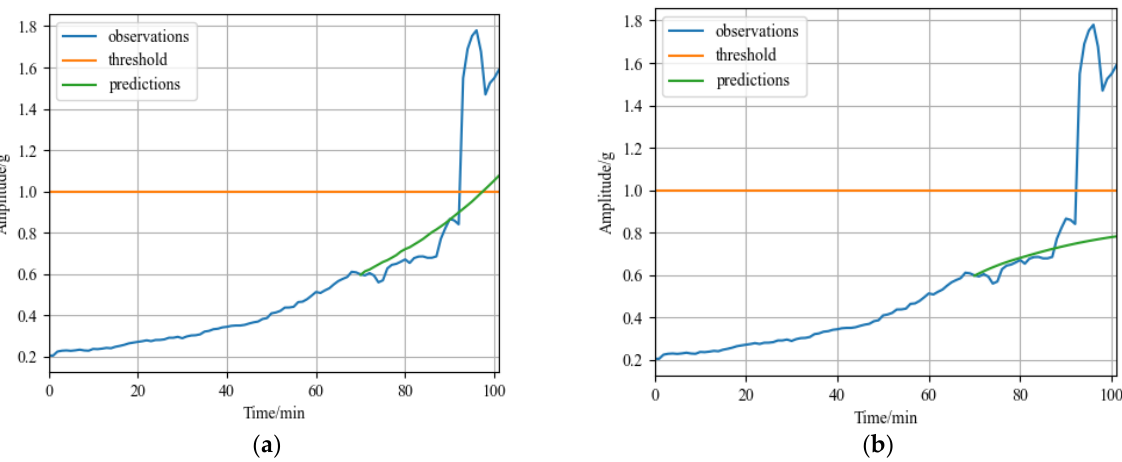
Figure 11. Comparative experiment results of bearing1_3 in XJTU-SY dataset: ( a ) RUL prediction result of CNN model; and ( b ) RUL prediction result of LSTM model.